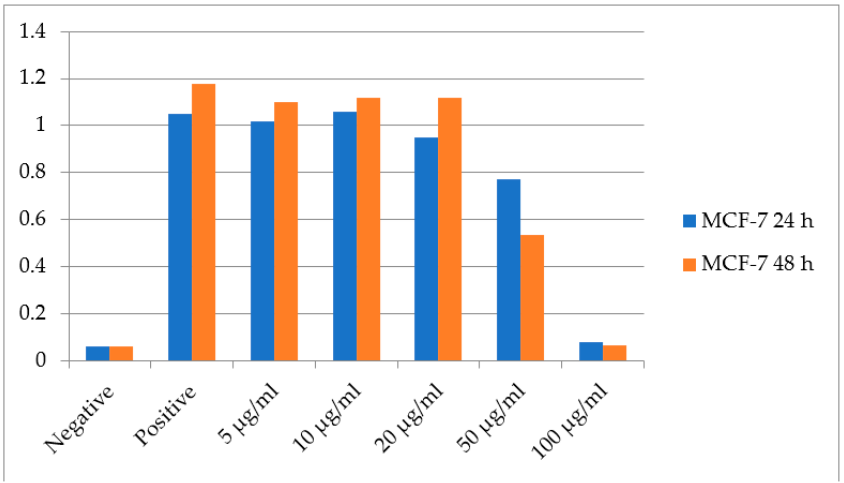
Figure 2. The results of MTT assay showing the effects of humic acid on human breast cancer cells MCF-7 at different concentrations for 24 and 48